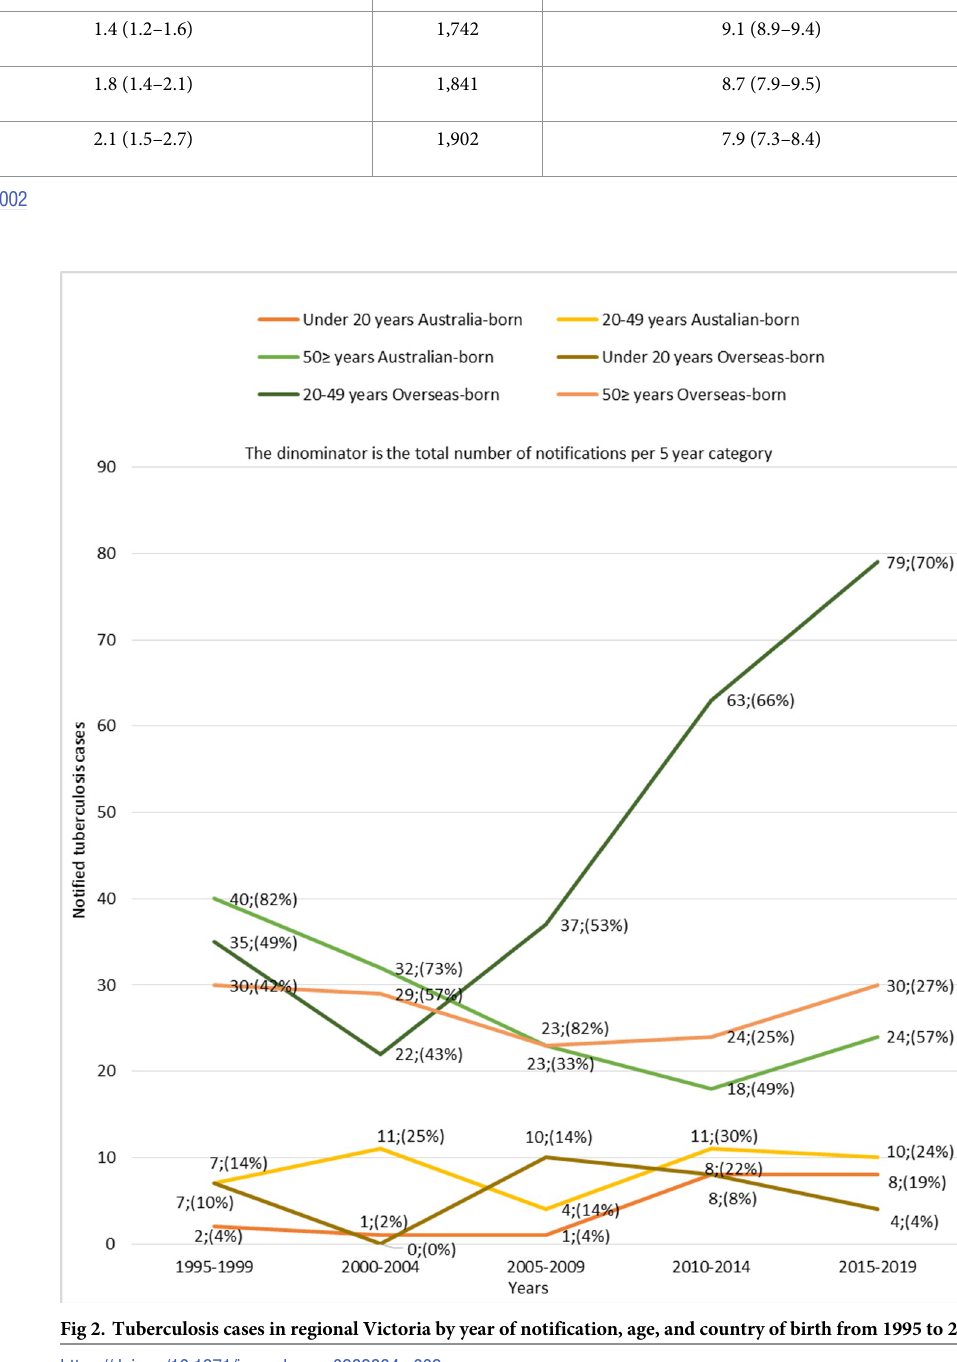
PLOS ONE | https://doi.org/10.1371/journal.pone.0282884 March 21,